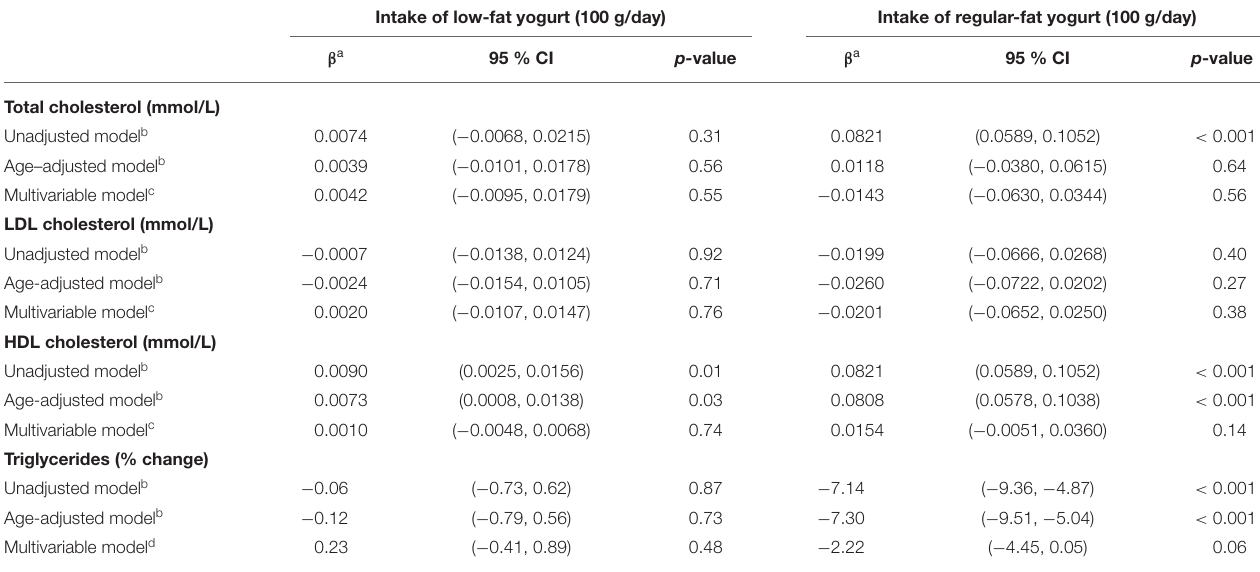
TABLE 3 | Linear regression coefficients for the associations between blood lipids and intake of low-fat yogurt and intake of regular-fat yogurt. The Tromsø Study: Tromsø7.